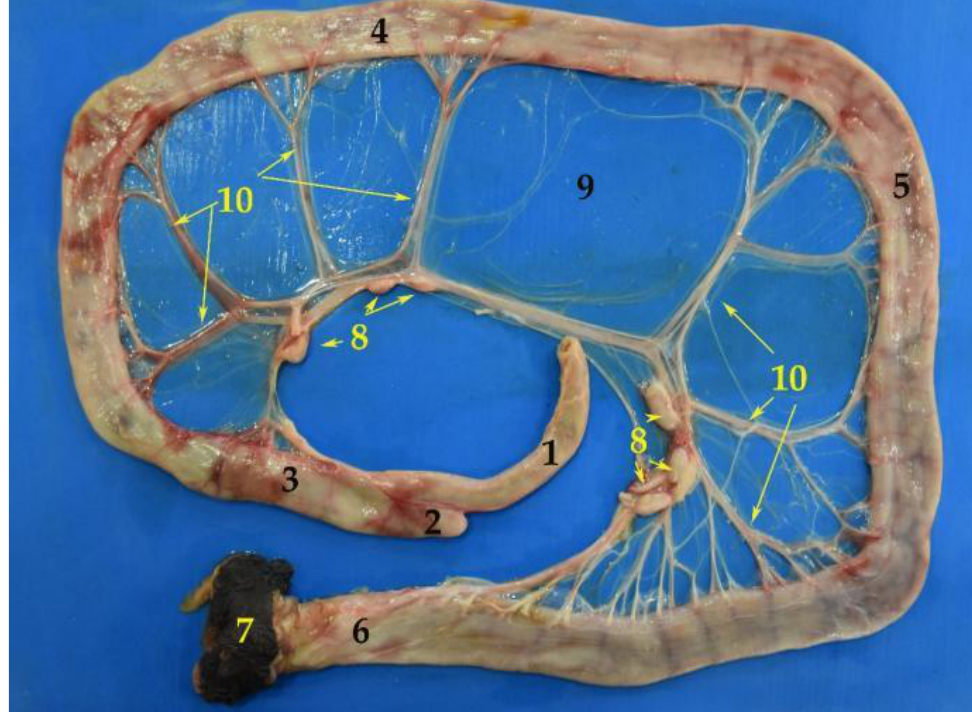
Figure 20. Image of the isolated large intestine. ( 1 ) Ileum; ( 2 ) cecum; ( 3 ) ascending colon; ( 4 ) transverse colon; ( 5 ) descending colon; ( 6 ) rectum; ( 7 ) anus; ( 8 ) lymph nodes; ( 9 ) mesocolon; ( 10 ) mesenteric vessels.